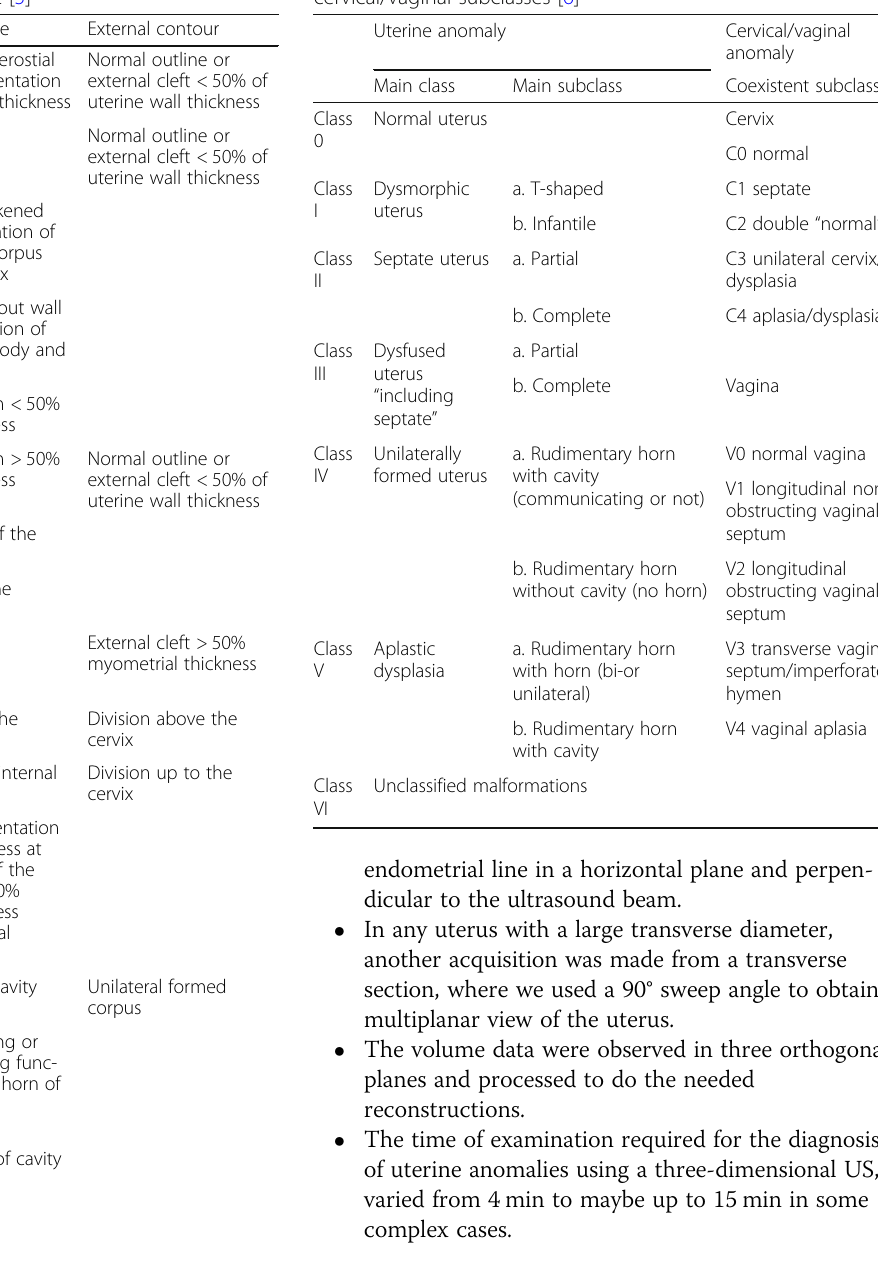
Table 1 Ultrasound criteria for the classification of congenital uterine anomalies by ESHRE – ESGE [5]